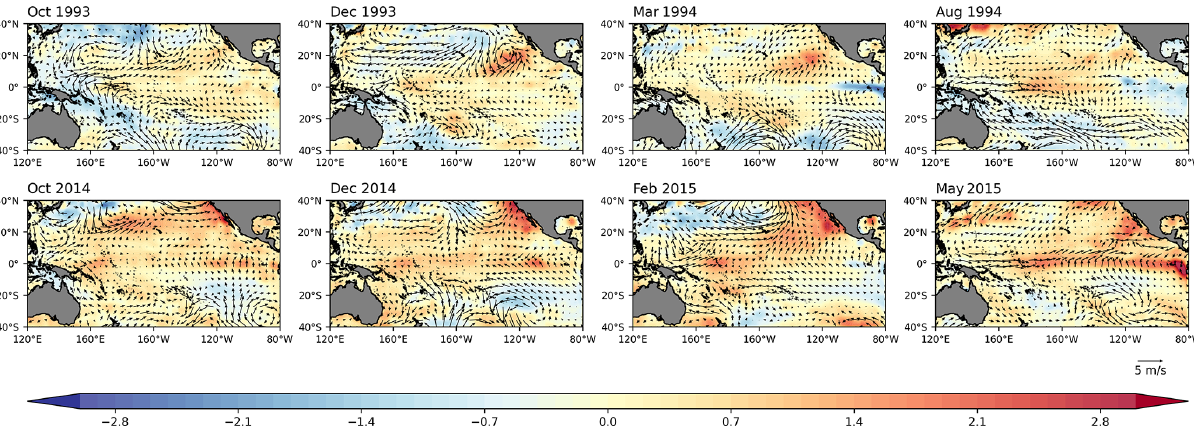
Figure 17. The SST and 10m wind-vector anomalies for the different seasons before the 1994–1995 CP El Niño and 2015–2016 EP El Niño events.